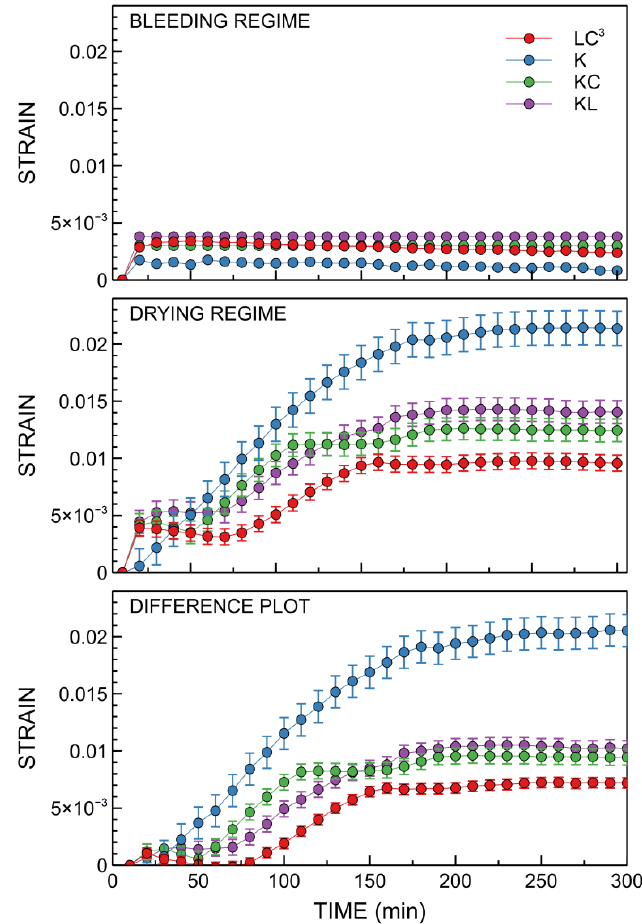
Figure 8. Plastic shrinkage measured by X-ray imaging for the fresh binders. Error bars are based on the estimated precision [37].